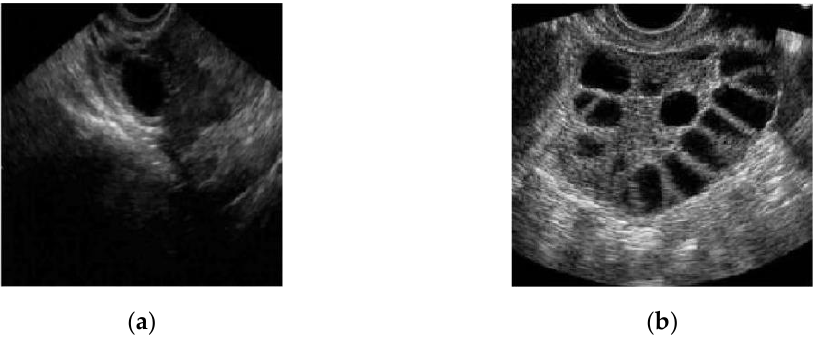
Figure 2. Ultrasound image of ( a ) a normal and ( b ) a polycystic ovary